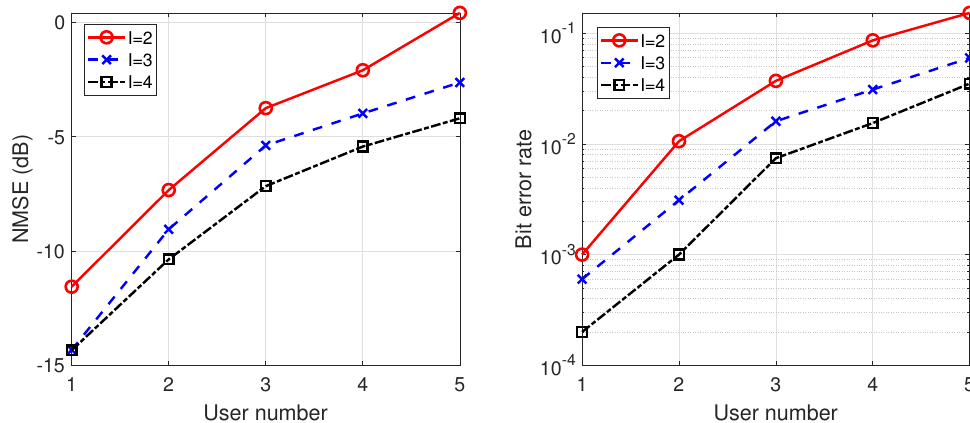
Figure 7. NMSE of estimated spreading waveform and BER of information sequence ( L = 63, G = 30, M = 100, SNR = − 5 dB).